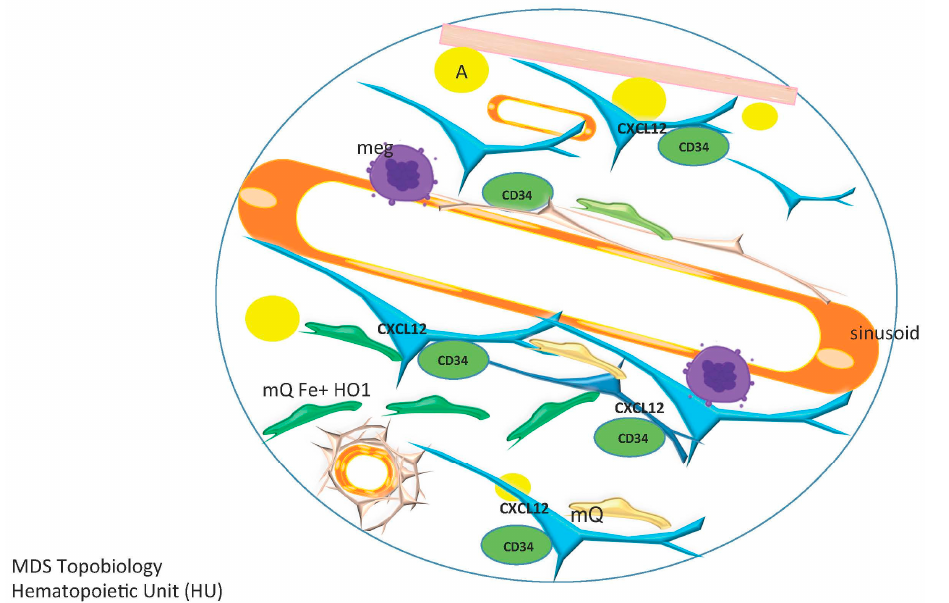
Figure 9. Topobiology of a Myelodysplastic Syndrome (MDS) Hematopoietic Unit (HU). In MDS patients there is a decrease in osteoblasts (accompanied by decreased CXCL12 in paratrabecular areas) and an increase and redistribution of MSC density such that the parenchyma is traversed by a dense MSC meshwork that aberrantly expresses CXCL12. The change in the distribution and secretion pattern of MSCs leads to a re-location of CD34+ hematopoietic progenitor stem/ cells (HPSCs) to the parenchyma, where they are in the proximity of increased iron overloaded macrophages (mQs) overexpressing heme oxygenase-1 (HO1).